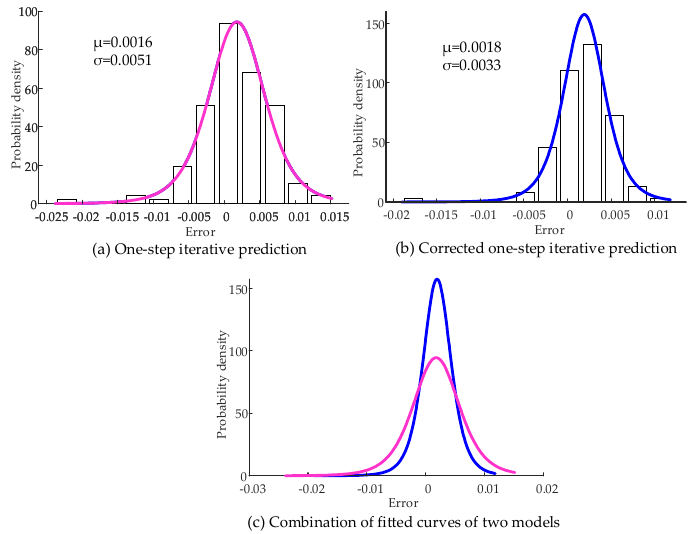
Figure 10. Frequency density histogram and fitting curve.